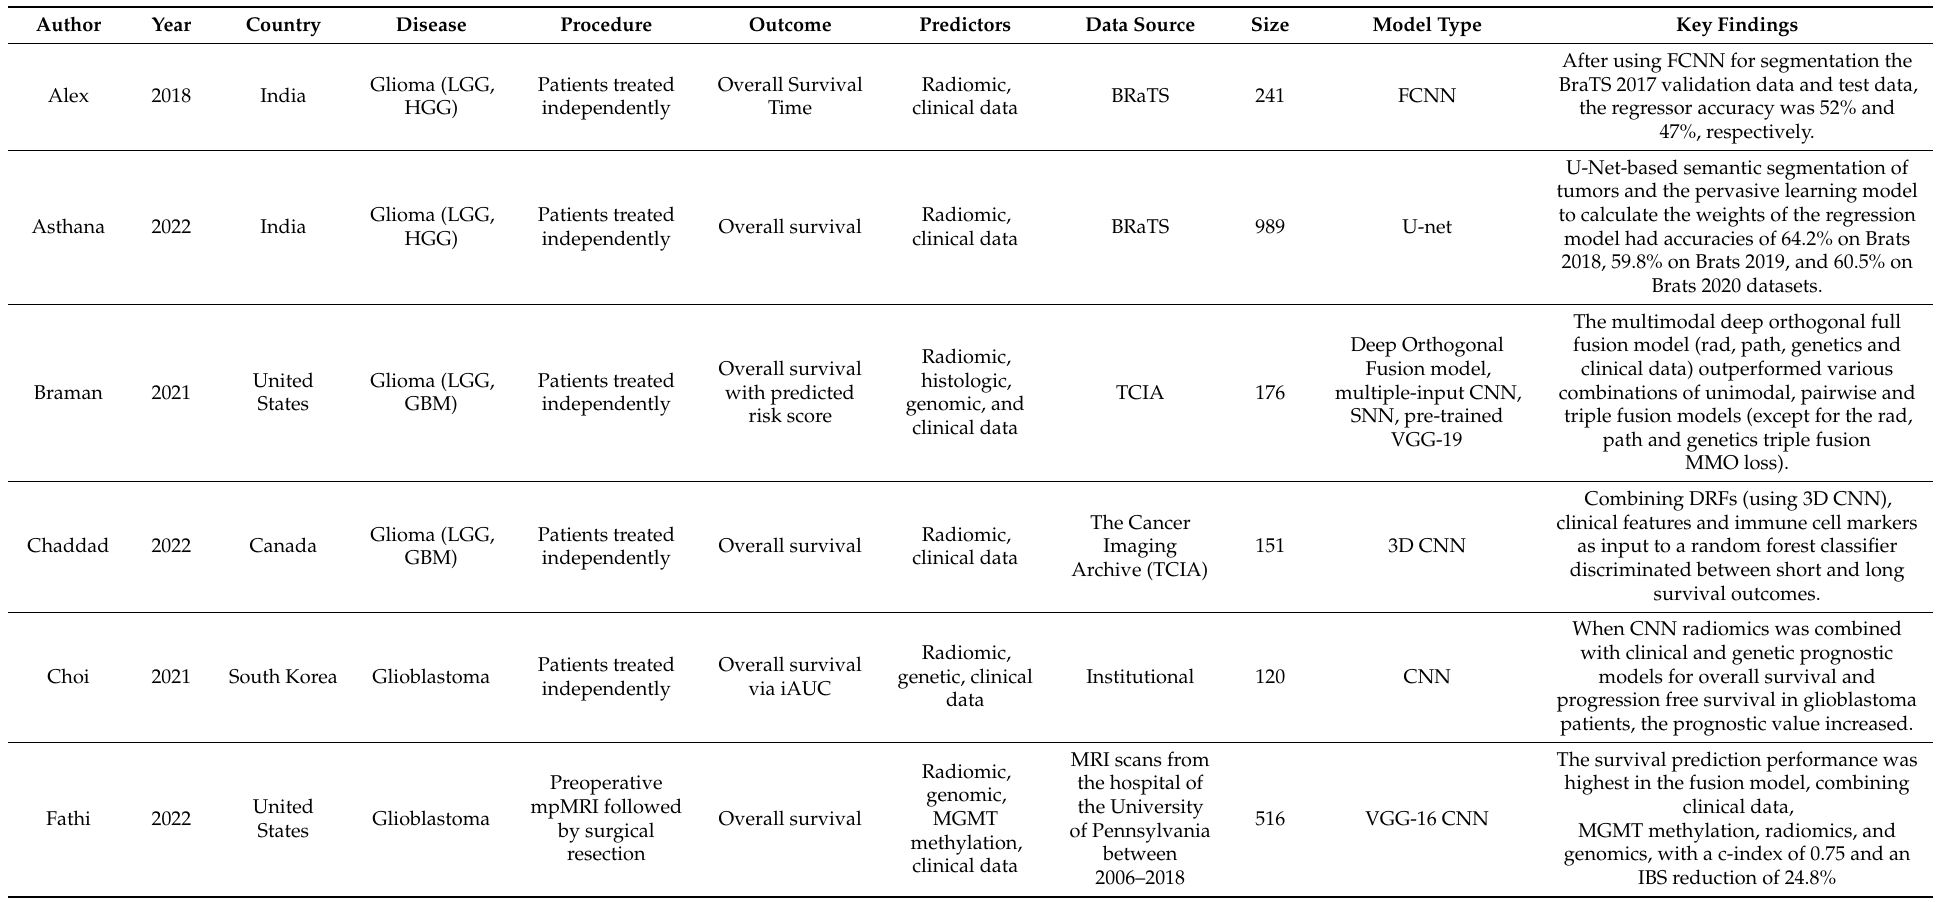
Table 1. Summary of studies